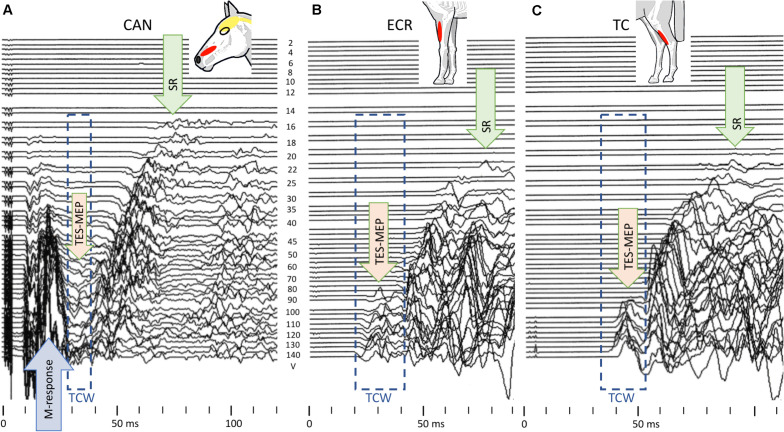
TES-mMEP landscape plots of the TES-mMEPs of the CAN (A), ECR (B), and TC (C) muscle groups illustrating the close relationship between stimulation threshold voltages of caninus muscle (CAN) responses (M-response) from extracranial elicited facial nerve axons (A) and the also assumed extracranial elicited SRs (example from case 4). Stimulation thresholds: M-response: 16 V, SR: for CAN 14 V; ECR and TC 22 V, and TES-mMEP all muscle groups: 80–90 V. Note that the TCW of the CAN mMEPs is smaller than for the two mMEP series due to squeezing by leading M-responses elicited by direct activation of facial nerve axons.